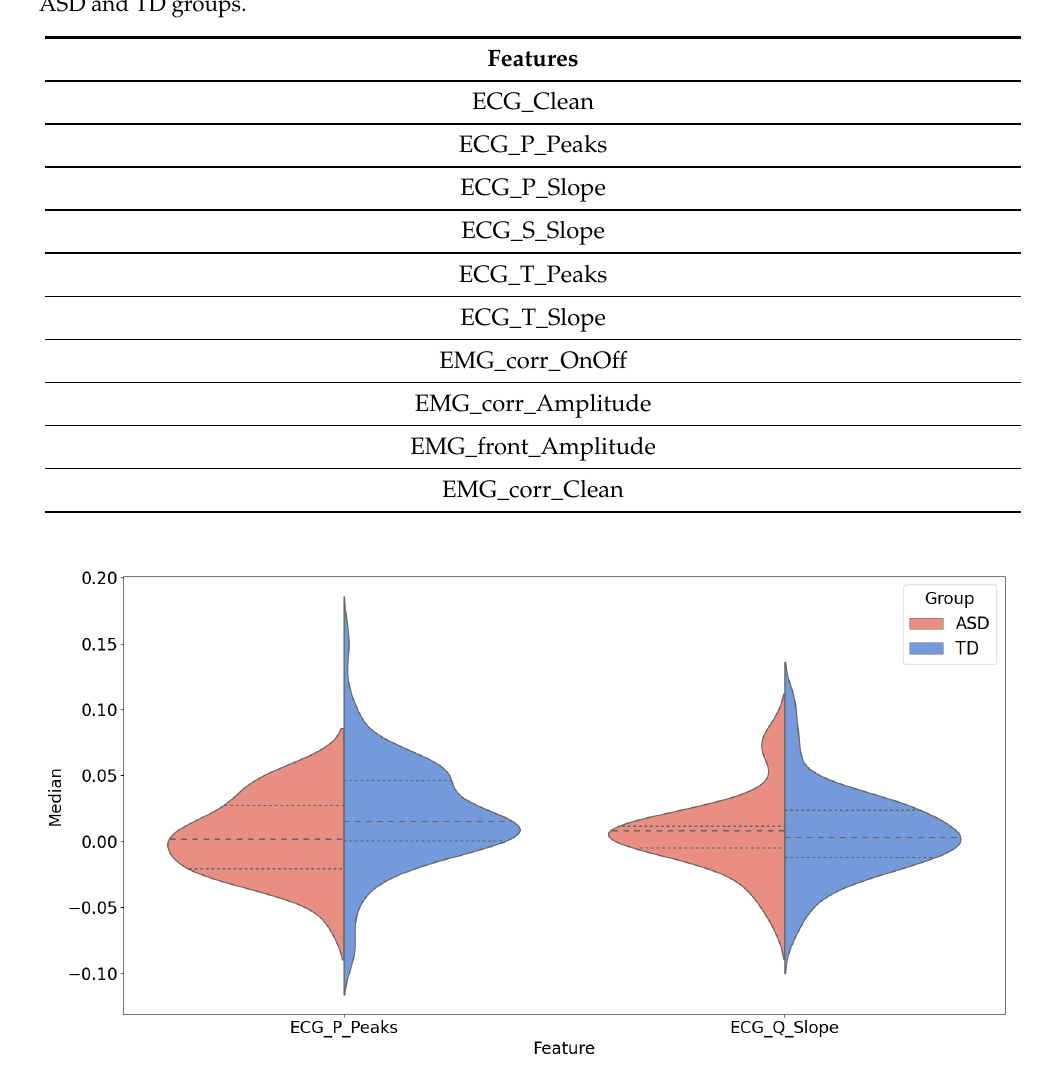
Figure 3. Violin plots of the ECG_P_Peaks and ECG_Q_Slope for the ASD and the TD groups. Physiological-Based ASD